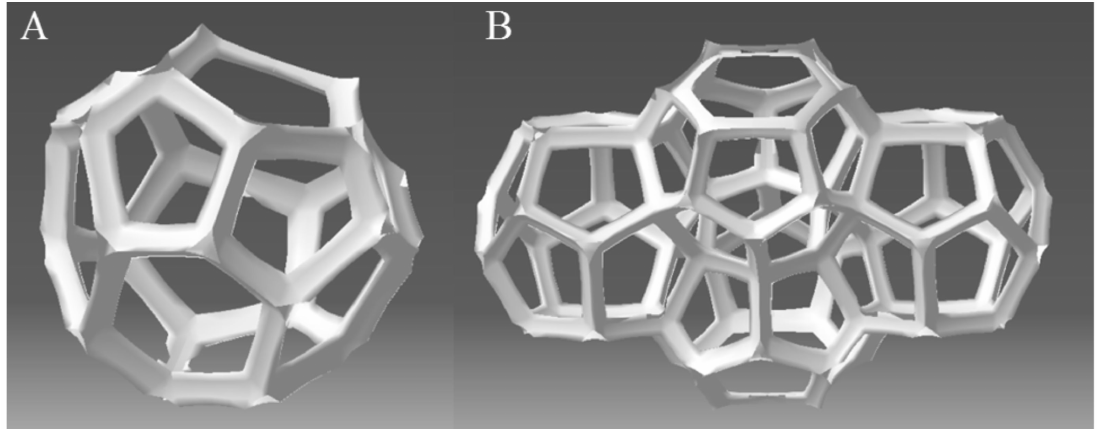
Figure 9. Single Weaire–Phelan cell ( A ); combined Weaire–Phelan cells ( B